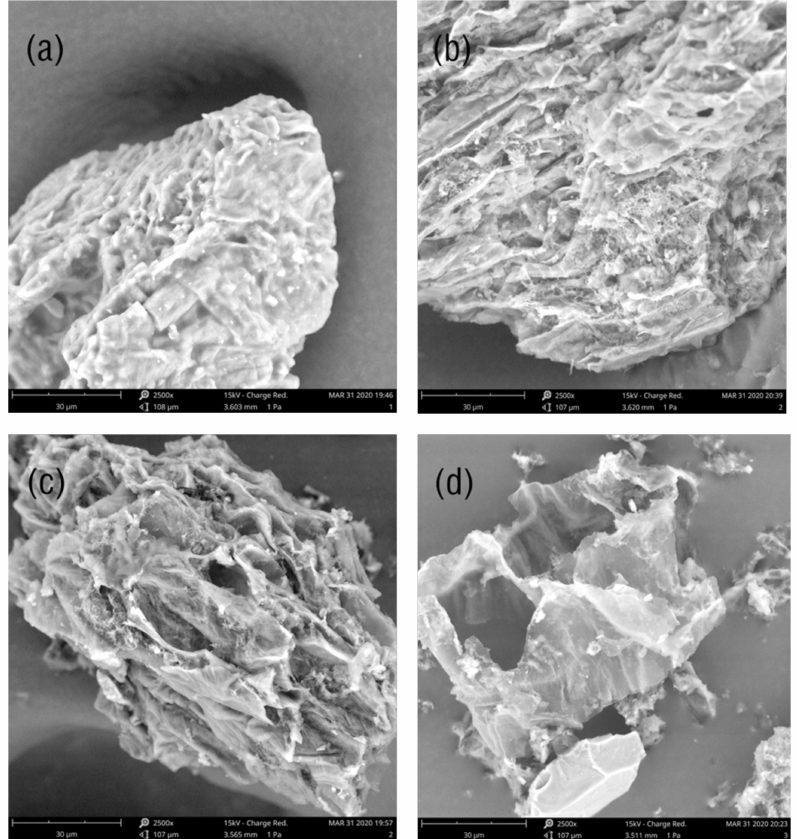
Figure 11. Scanning electron microscopy (SEM) images of Angelica sinensis sample